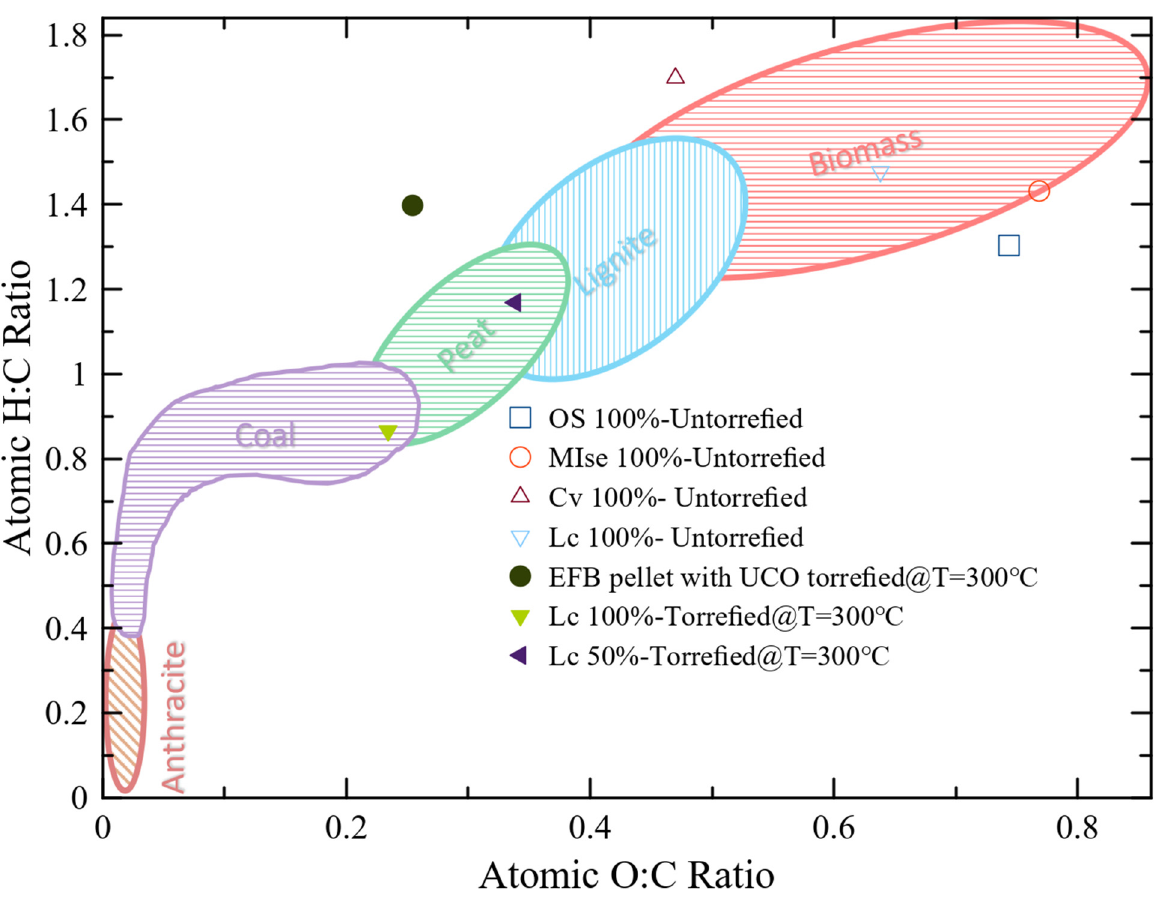
Figure 4. Van Krevelen diagram redrawn using the data from [74]. The Van Krevelen diagram also compares torrefied and untorrefied biomass. Torre- fied biomass has a higher carbon content and decreases oxygen and hydrogen contents compared to untorrefied biomass. The other aspect is that co-torrefied biomass has lower